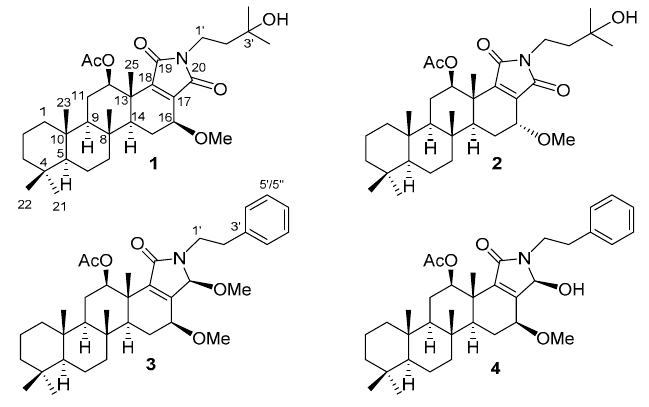
Figure 1. Scalalactams A–D ( 1 – 4 ).